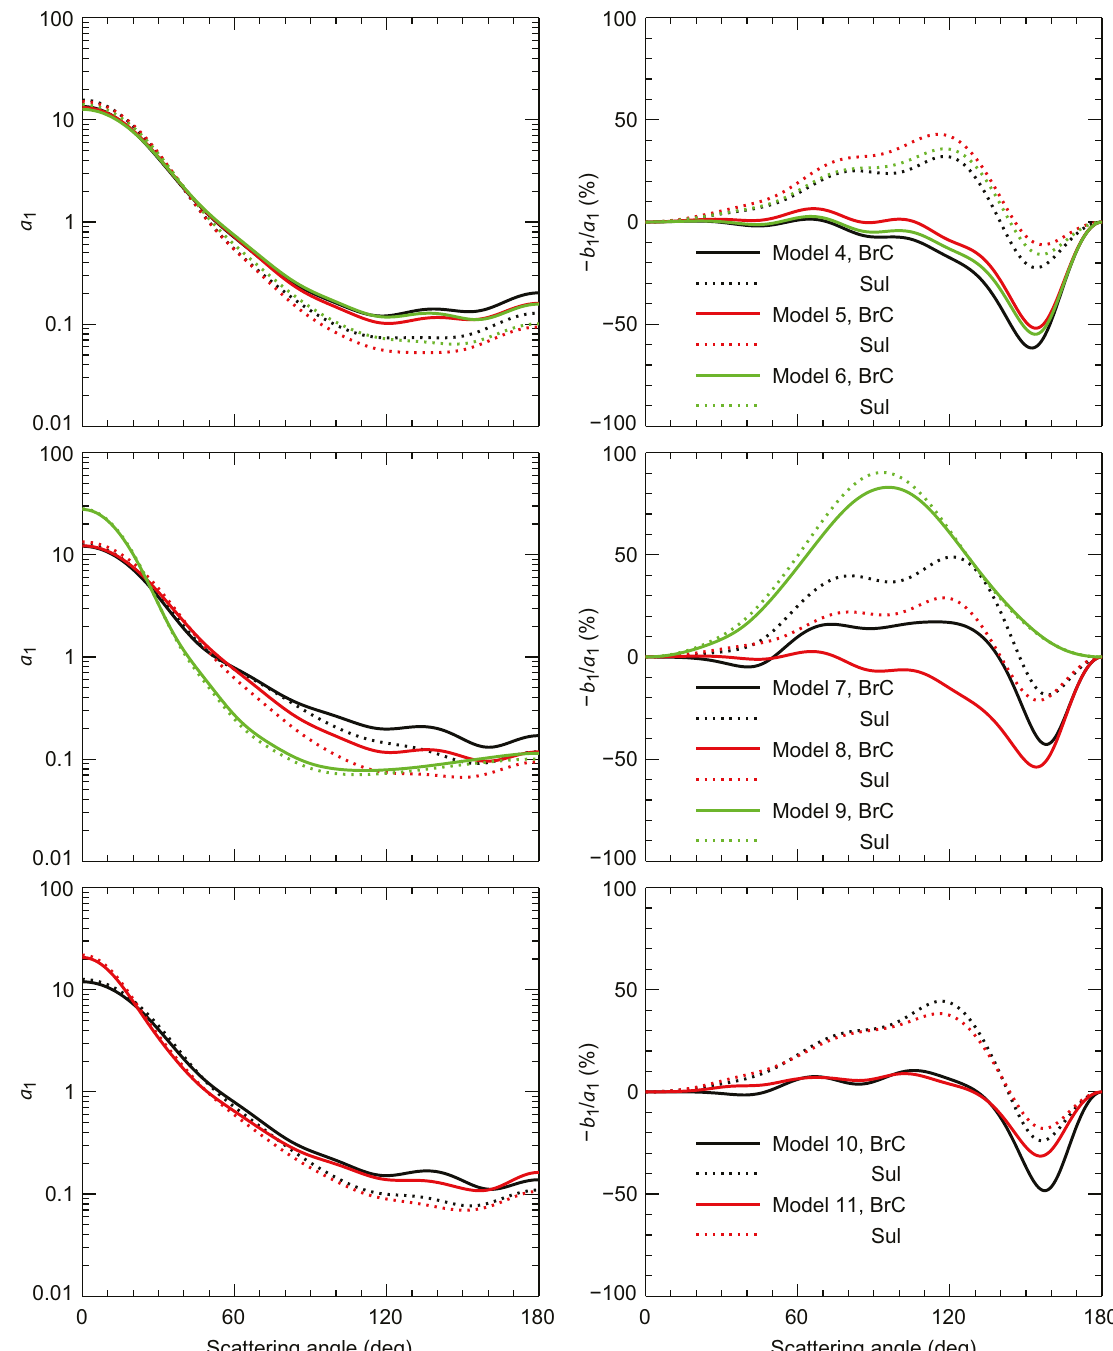
Figure 10. As in Figure 8, except that now the solid and dotted curves represent the results calculated for soot-containing aerosols with brown-carbon (BrC) and sulfate (Sul) host/coating, respectively.